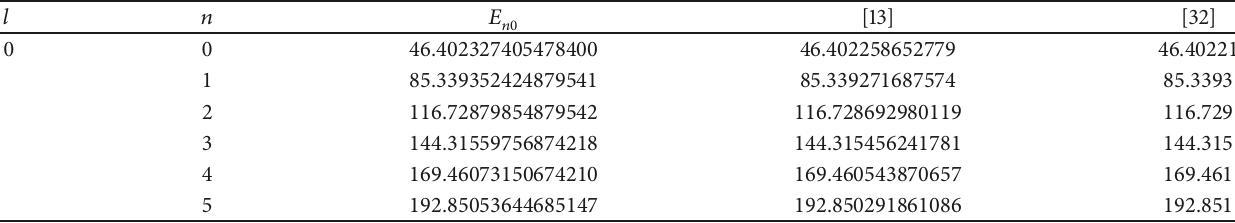
Table 5: Comparison of eigenvalues of 𝑉(𝑟) = −1/𝑟 + 100𝑟 for 𝑛 states.